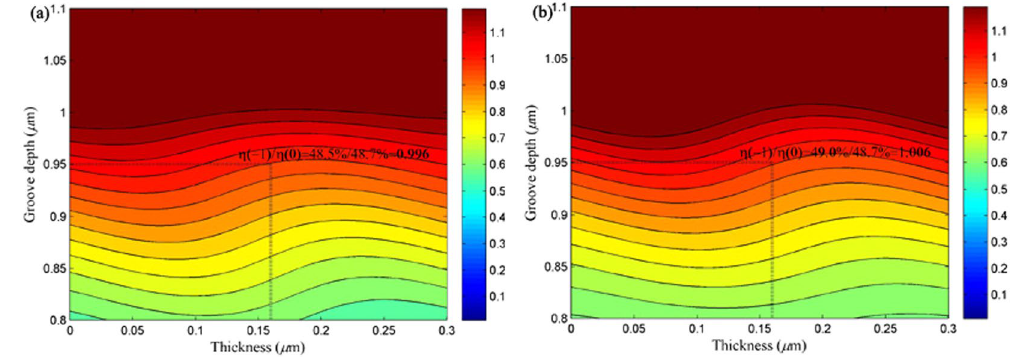
Figure 7. The grating groove depth and thickness versus the contour of the efficiency’s ratio between the − 1st order and the 0th order: ( a ) TE-polarized light and ( b ) TM-polarized